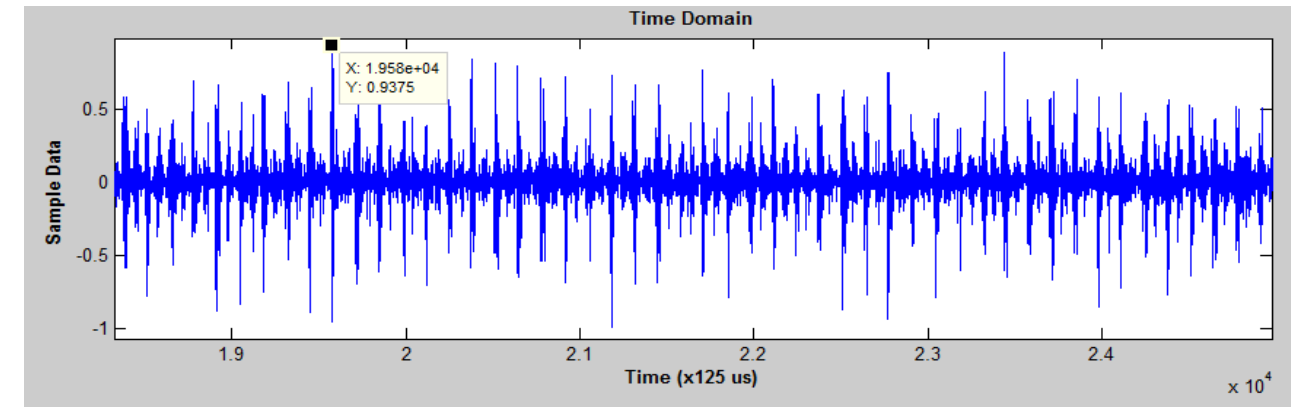
Figure 12. Tracking wave pattern [35].